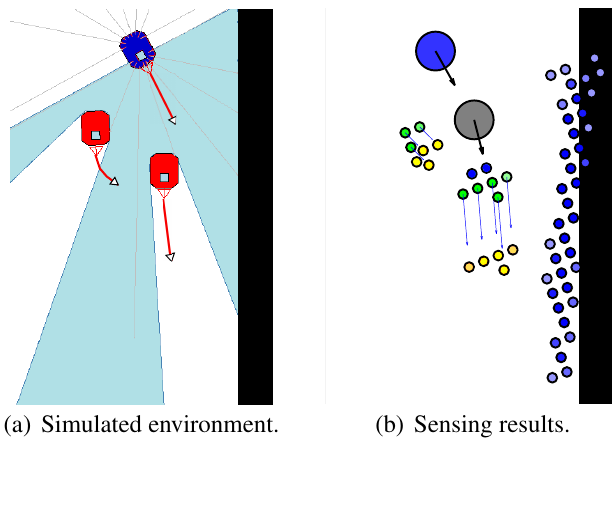
Figure 3. Simulated environment and sensing results.